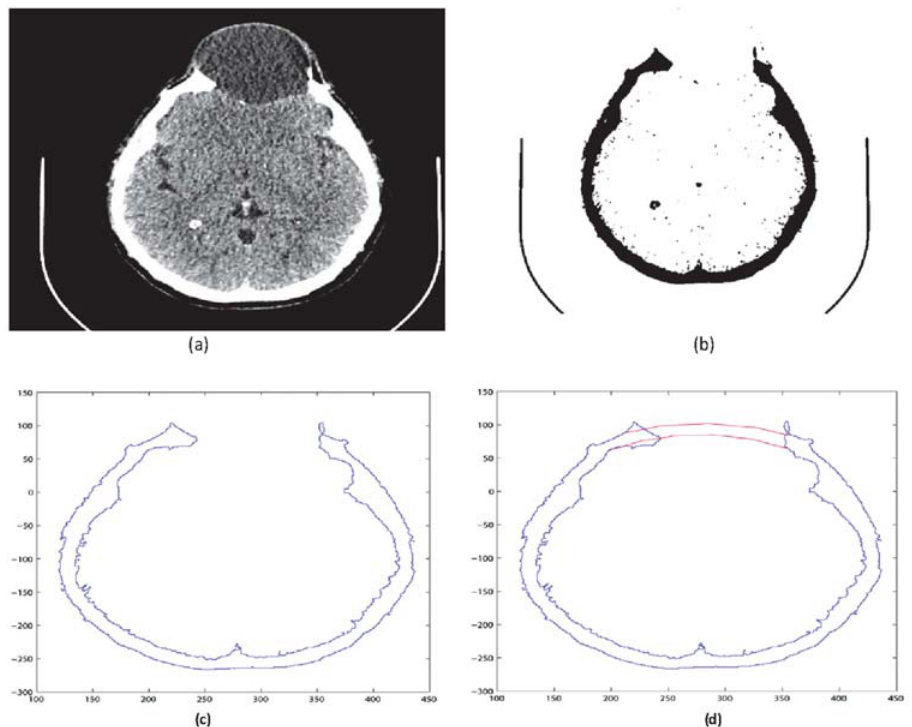
Fig 9. CT scanned data of slice 131. (a)Original image (b) Binary image (c) Boundary (d)Reconstructed missing part using rational cubic Ball